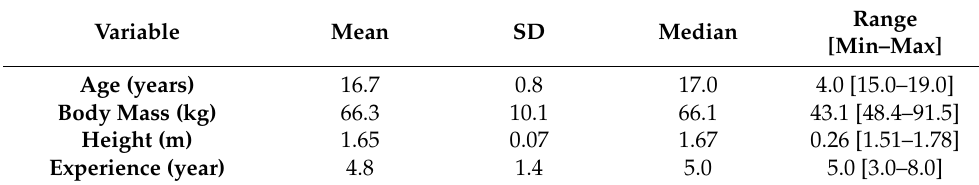
Table 1. Descriptive statistics ( n =